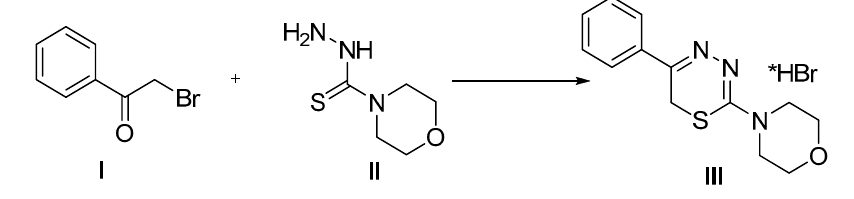
Figure 2. Chemical synthesis of thiadiazine derivatives.